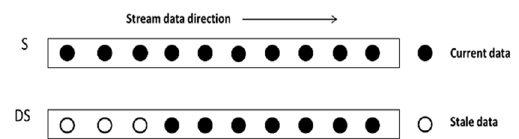
Fig. 1 Stream data at t N .In the figure 1, the black solid circle represents the current data, and the black hollow circle represents the stale